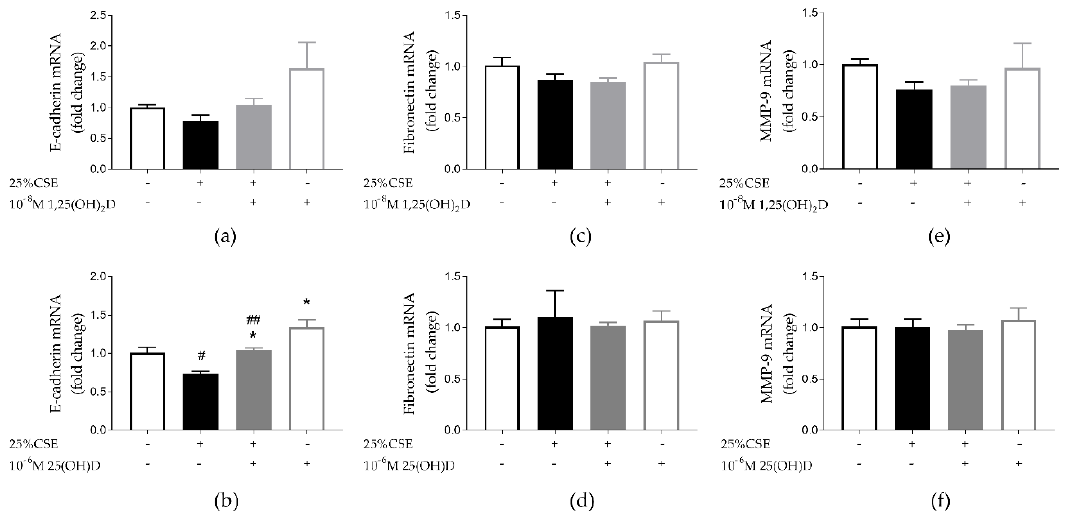
Figure 3. Effect of CSE and vitD on airway remodeling in 16HBE cells. ( a ) Neither 25% CSE, nor